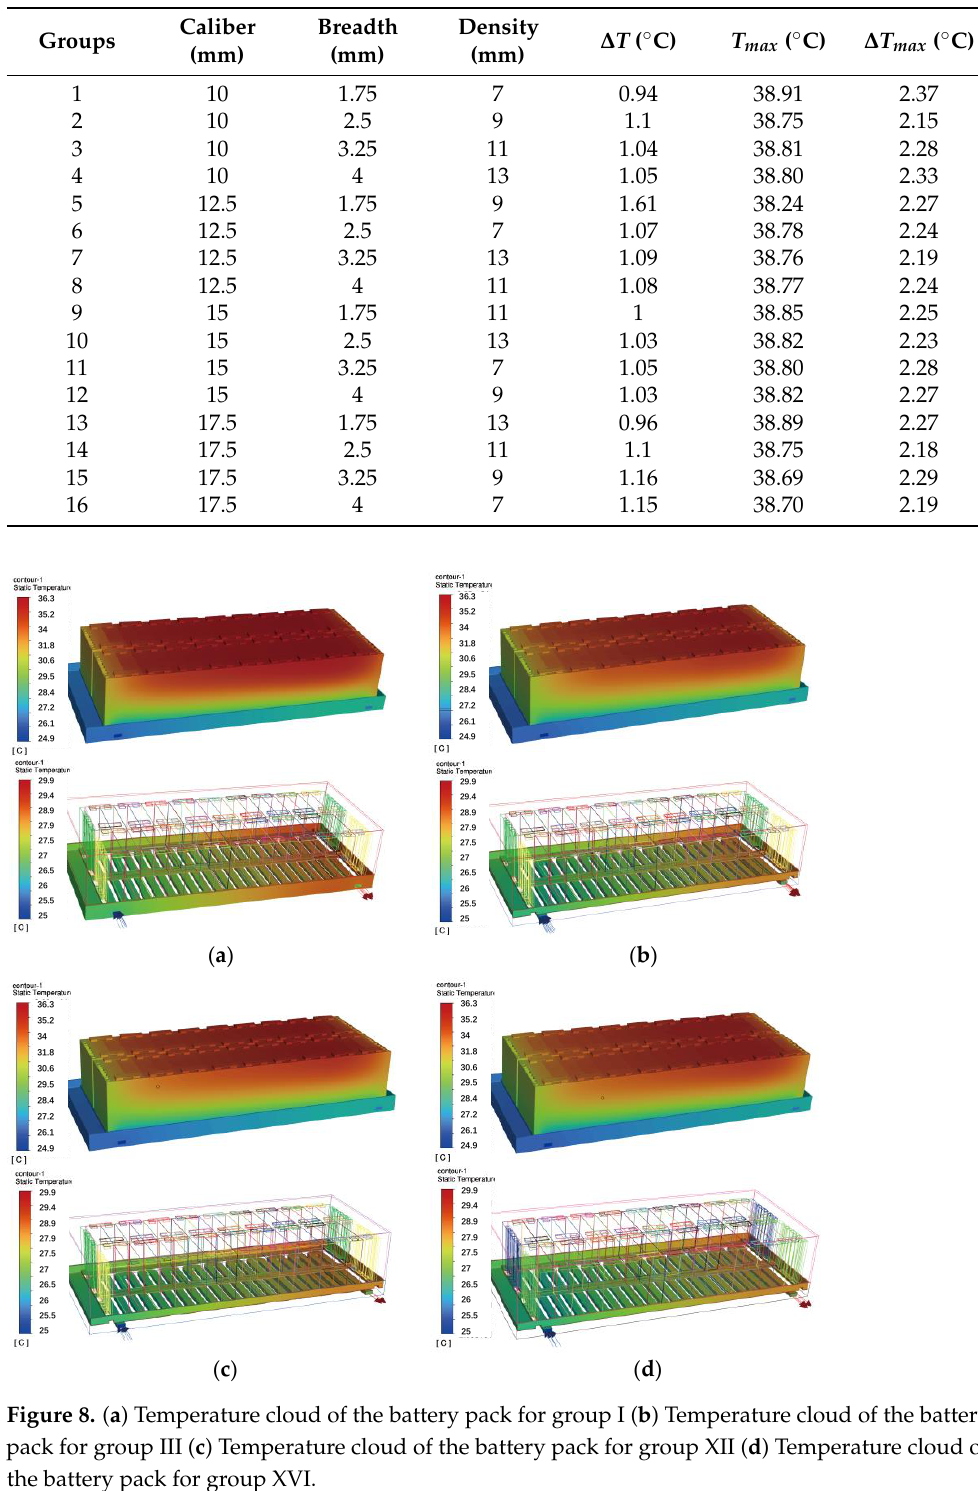
Table 5. Parameter settings and results of 16 sets of orthogonal experiments. Table 5 . Parameter settings and results of 16 sets of orthogonal experiments.